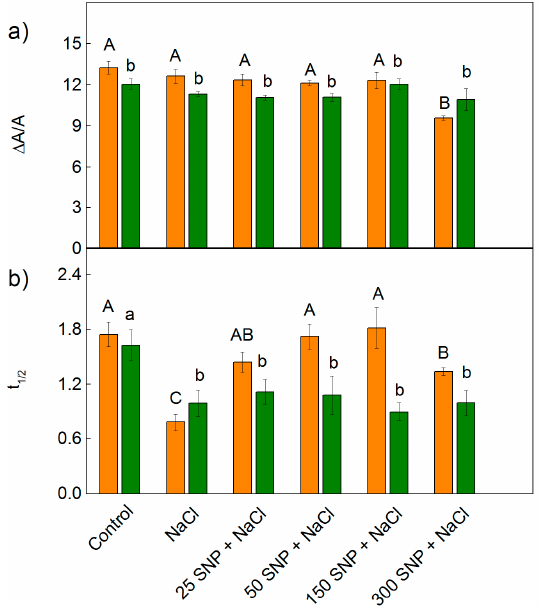
Figure 10. Effects of SNP on the relative changes in ( a ) the amount of P700 + ( ∆ A/A) and ( b ) half time (t 1/2 , sec) of dark reduction of P700 + in the leaves of the two sorghum varieties (Albanus—orange bars and Shamal—green bars) under salt stress. Mean values ( ± SE) were calculated from eight independent measurements. The significant differences among treatments at p < 0.05 are indicated by different letters (uppercase for Albanus and lowercase for Shamal).